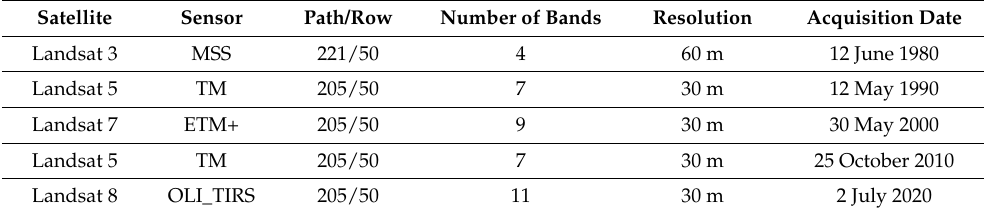
Table 1. Landsat image information (1980, 1990, 2000, 2010 and 2020) for Dakar region, Senegal. Satellite Sensor Path/Row Number of Bands